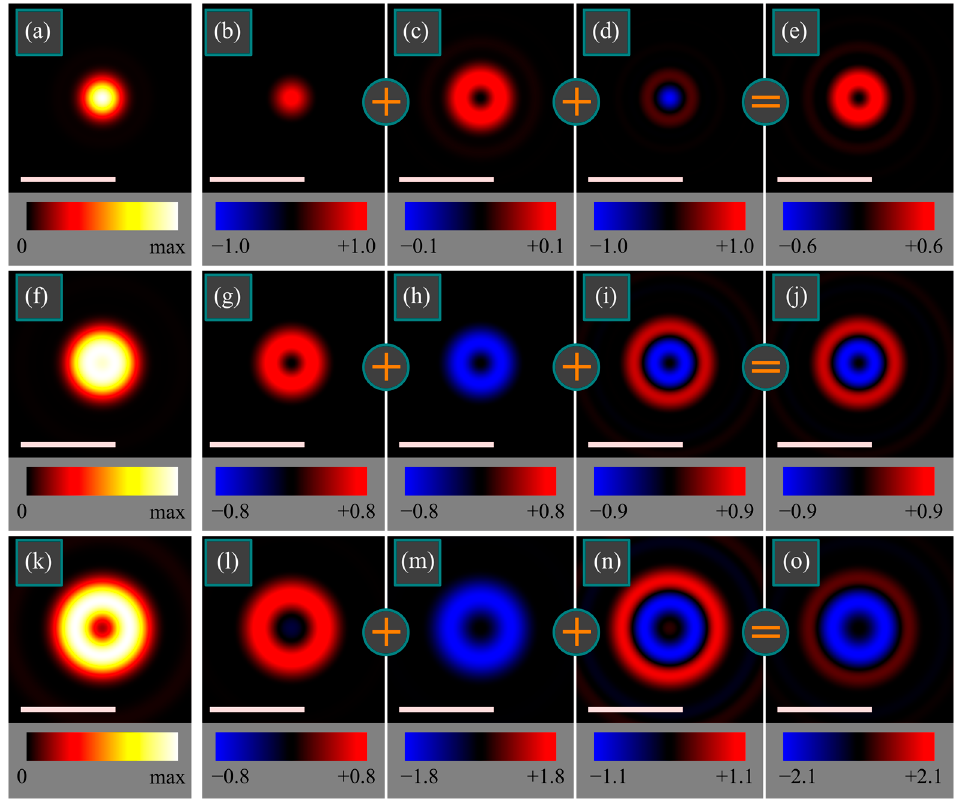
Figure 1. Intensity distributions ( a , f , k ), as well as distributions of the SAM (10) ( b , g , l ), OAM (14) ( c , h , m ), second term in Equation (29) ( d , i , n ), and full AM (12) ( e , j , o ) in the tight focus of a plane vortex field ( A ( θ ) = 1) with right circular polarization (1) for n = 0 ( a – e ), n = − 1 ( f – j ), n = − 2 ( k – o ) at the following parameters: wavelength λ = 532 nm, focal length of the focusing lens f = 10 μ m, numerical aperture sin θ 0 = 0.95, computation domain 2 μ m × 2 μ m. Red and blue colors mean positive and negative values, respectively. Black color means zero. Numbers in the legends after each figure denote what the lightest blue and the lightest red color mean. The cale mark in all figures denotes 1 μ m.